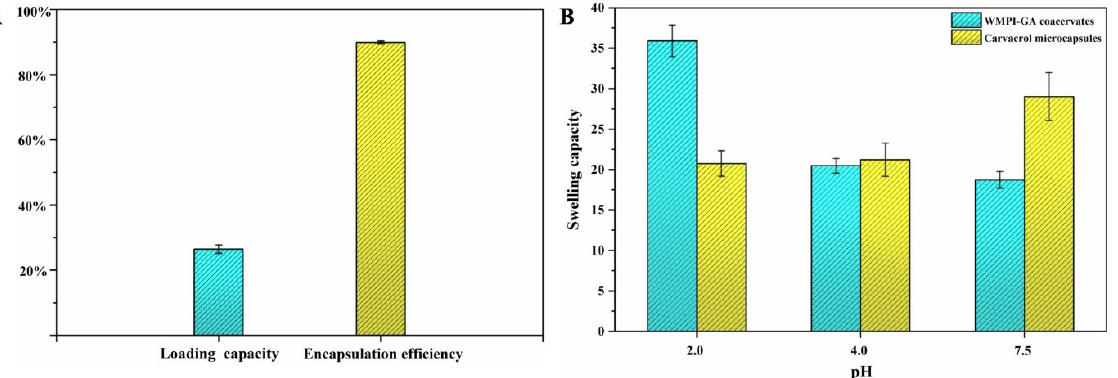
Figure 5. Encapsulation efficiency ( A ) and swelling capacity ( B ) of the carvacrol